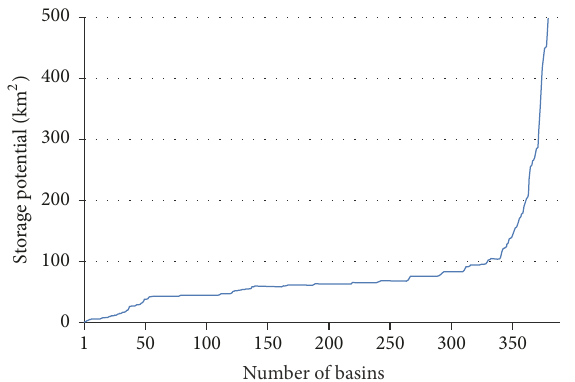
Figure 1: The statistical profile of CO 2 geological storage potential per square kilometer of 390 onshore basins in China.